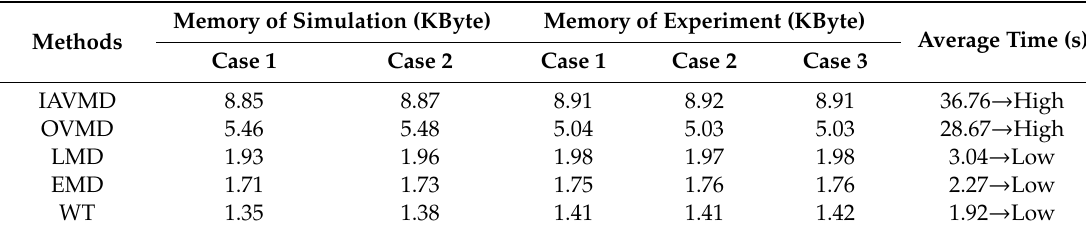
Table 7. Assessment of the time and memory cost of di ff erent